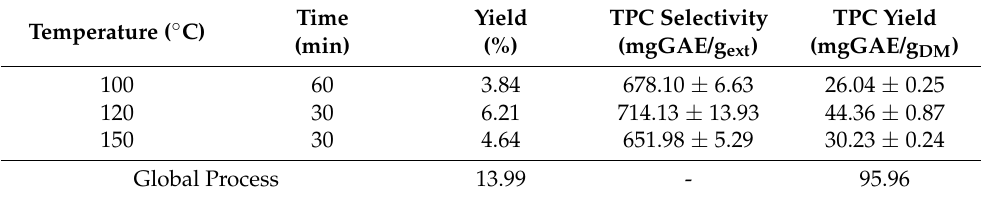
Table 9. Extraction yield and TPC analyses for triple sequential